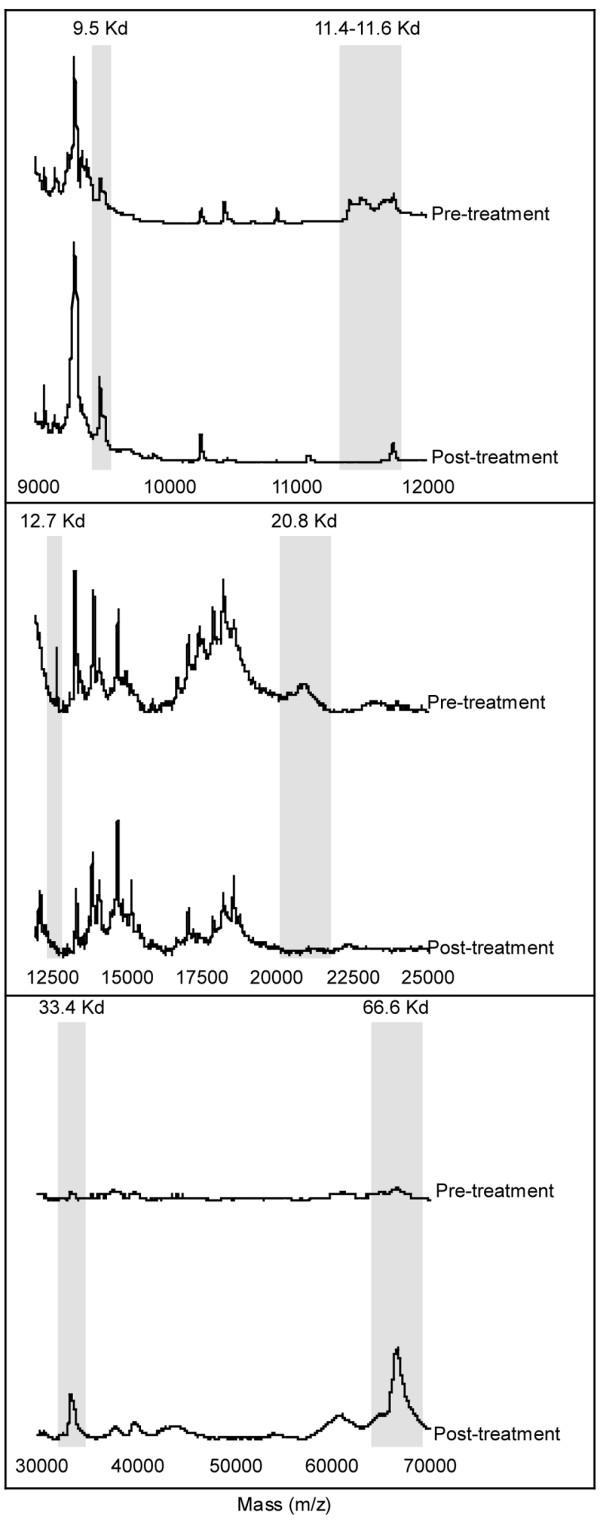
SELDI-TOF MS profiles for patients with SJIA treated conventionally. Six serum protein peaks can be clearly seen to have changed after conventional therapy. The profiles of a representative patient are shown here. Visually distinct peaks that were clearly different between pre- and post-treatment paired samples upon visual inspection of the profiles (in bold type in Table 1) are outlined in grey. Pre- and post-treatment spectra are shown on the same intensity scale in each frame. SELDI-TOF MS, surface-enhanced laser desorption/ionization time-of-flight mass spectrometry SJIA, systemic juvenile idiopathic arthritis.